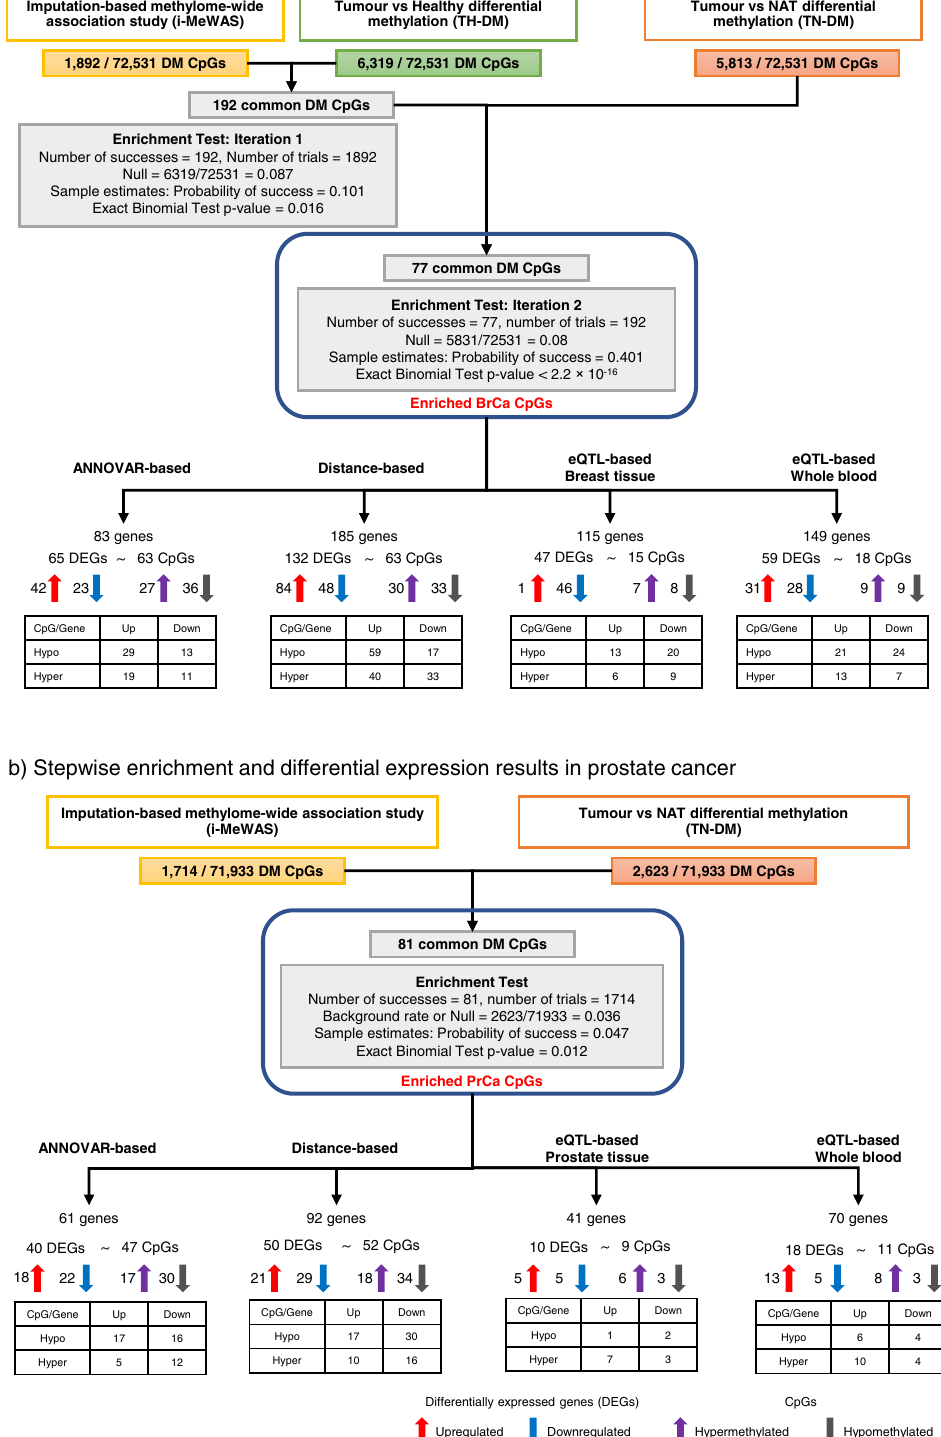
Fig. 2 Identi fi cation of cancer-associated CpGs and differential expression analyses of the associated genes. Results from the overlap step of the pipeline and differential expression analyses of the genes associated with the enriched CpGs in ( a ) breast cancer (BrCa) and ( b ) prostate cancer (PrCa). Due to the unavailability of healthy prostate methylation data, the overlap step in PrCa did not include differential methylation between tumour and healthy tissues. For differential expression analysis, the CpGs were annotated to genes through ANNOVAR-, distance- and eQTL-based approaches. The differential expression was conducted in the TCGA gene expression dataset using DESeq2 for ANNOVAR- and distance-based genes and using the GWAS summary statistics and FUSION for eQTL-based genes. Up and Down for gene in the matrix refer to up- and downregulated gene expression while Hypo and Hyper for CpGs indicate hypo- and hyper-methylation, respectively. CpGs cytosine-phosphate – guanine sites, DEGs differentially expressed genes, DM differentially methylated, NAT histologically normal tissue adjacent to the